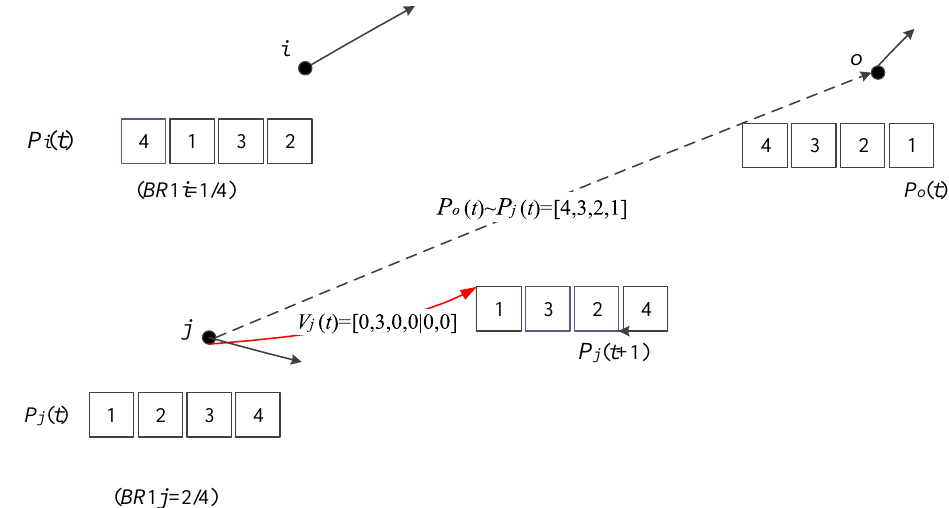
Figure 11. Particles p1 and p2 fly toward the target particle o.